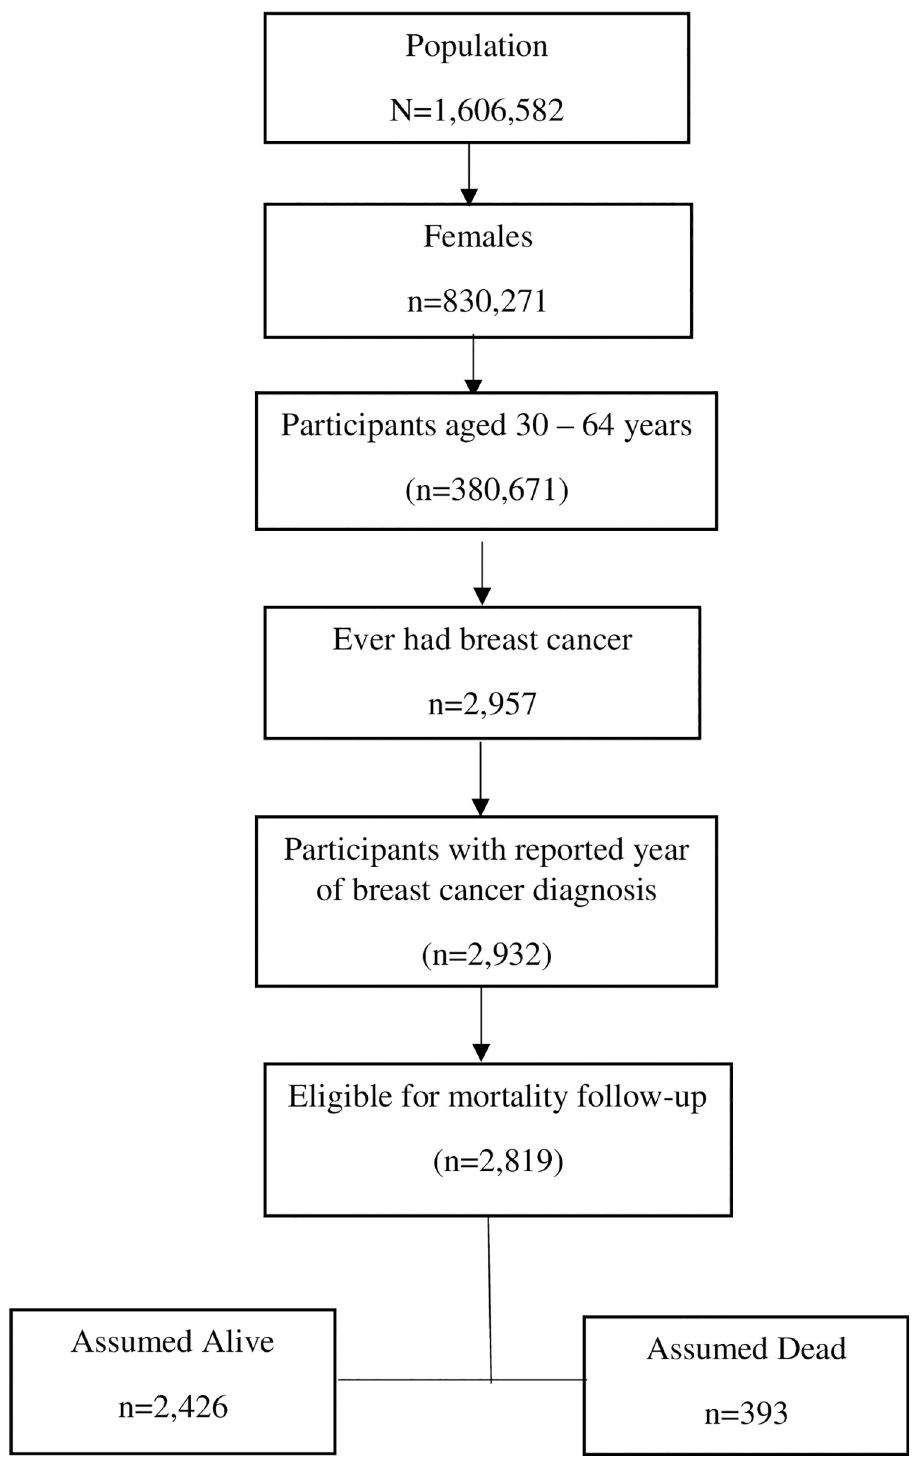
Fig 1. Study population with inclusion and exclusion criteria, NHIS 1998–2014.